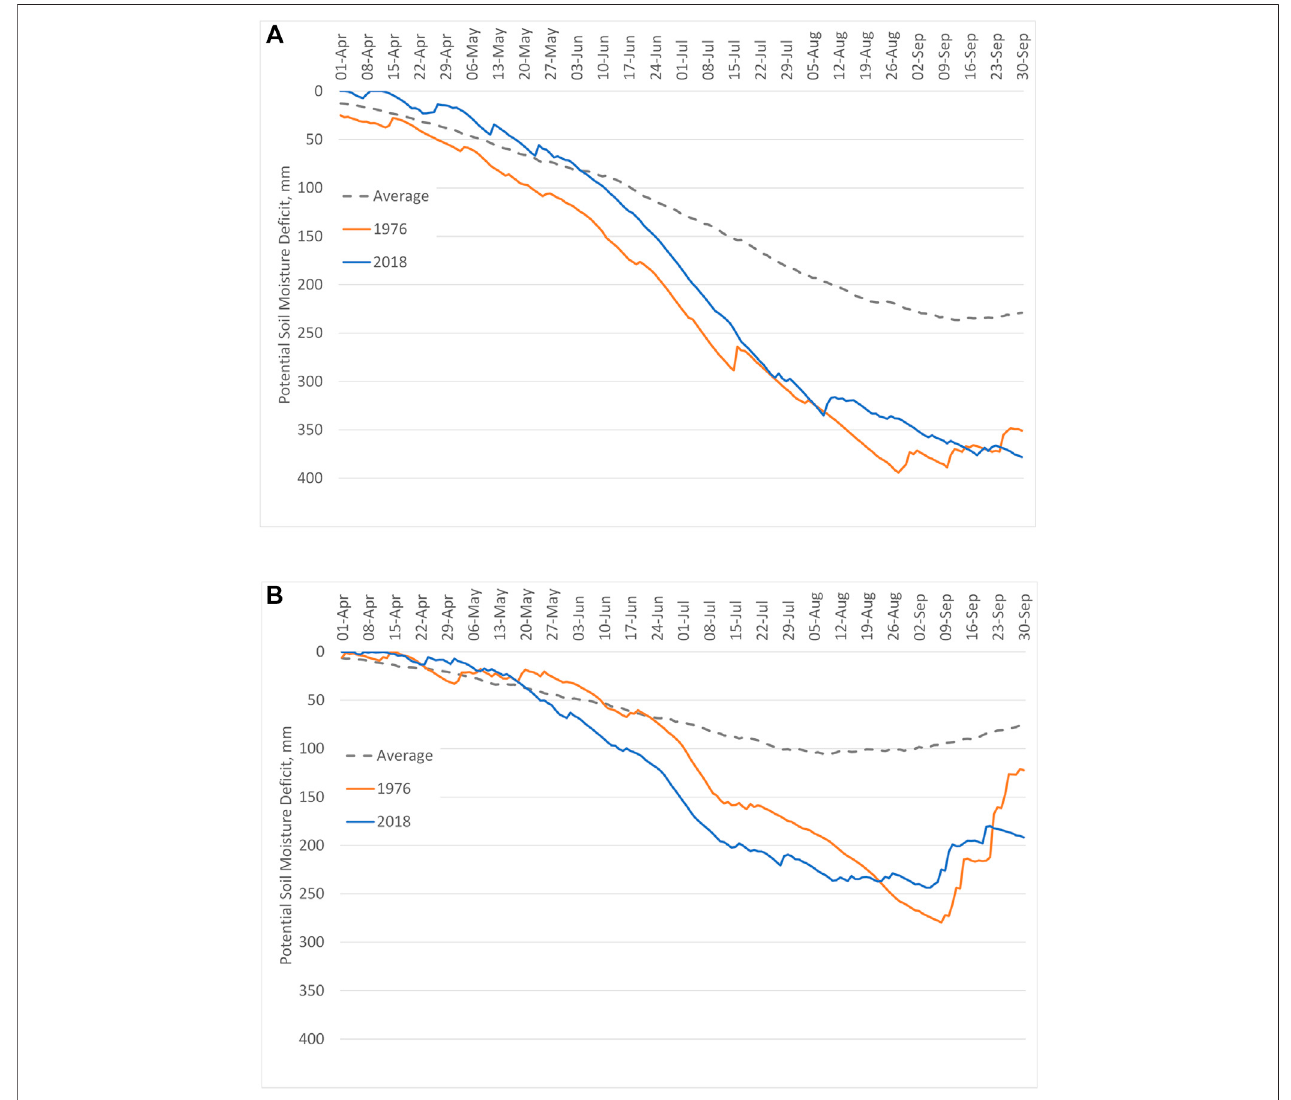
FIGURE 2| Potential soil moisture de fi cit pro fi les for (A) Cambridge and (B) Blackpool for 1981 – 2010 average, 2018 and the 1976 extreme drought year. Source: Knox and Hess (2019).